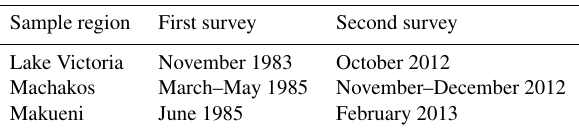
Table 1. Dates on which aerial sample surveys were conducted. Sample region